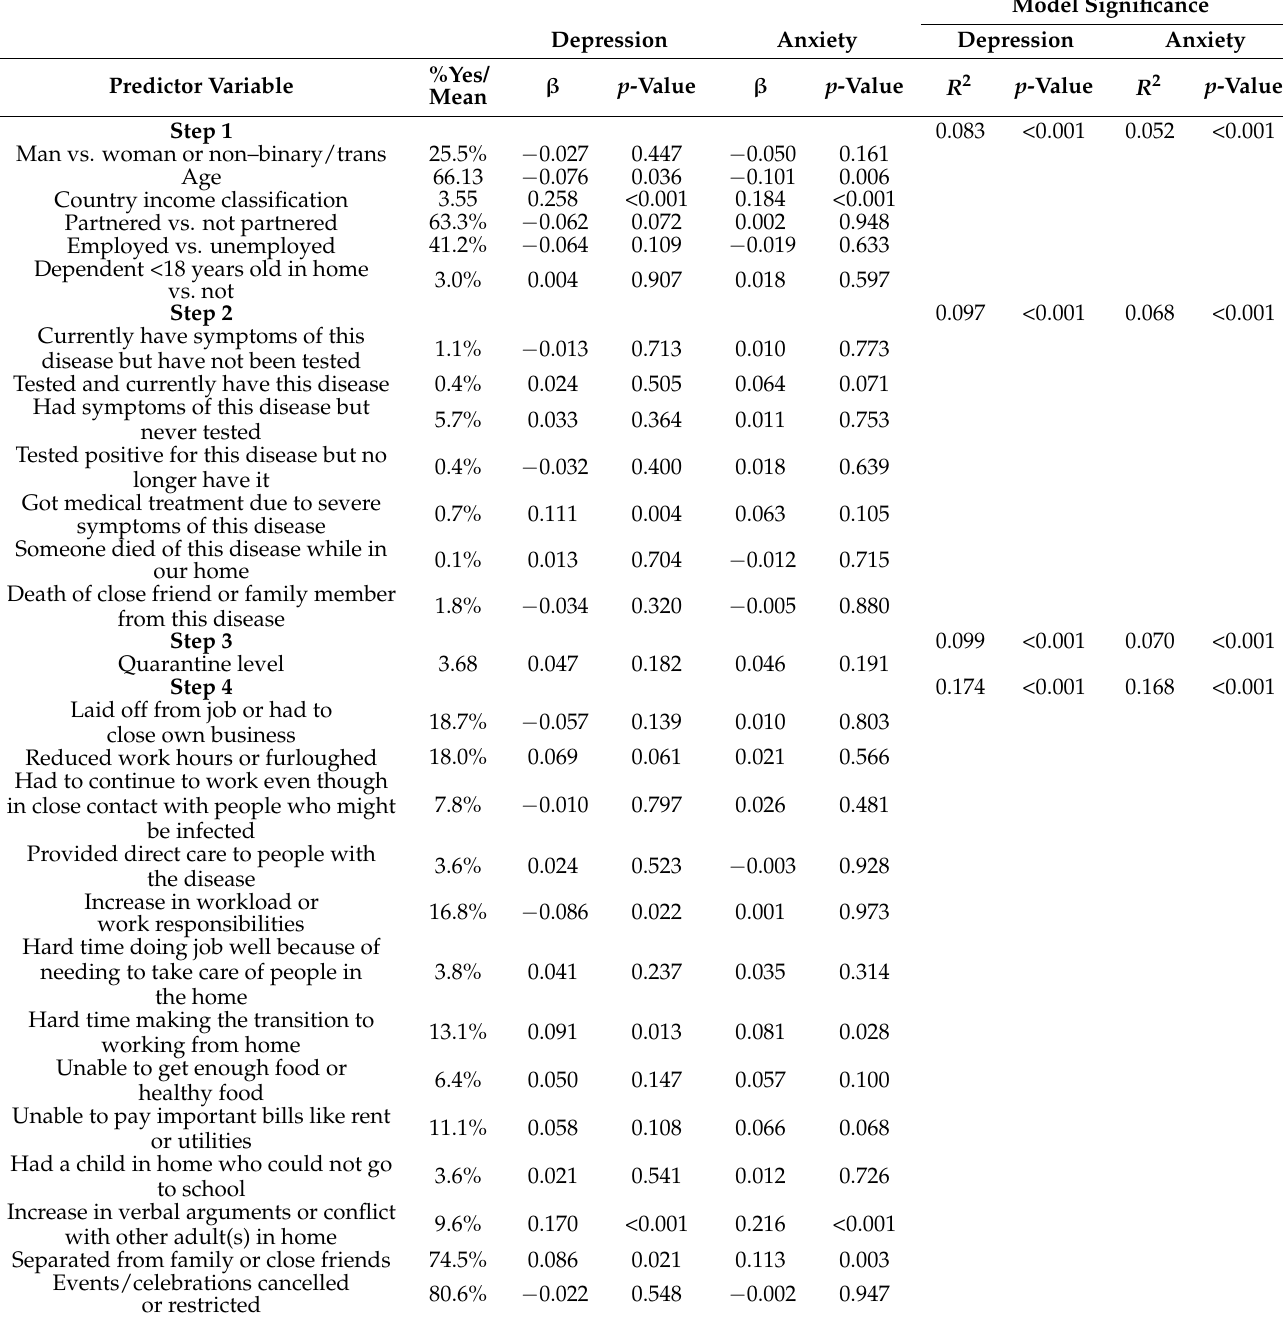
Table 3. Depression and Anxiety Multiple Regressions with Standardized β -weights Presented from Step